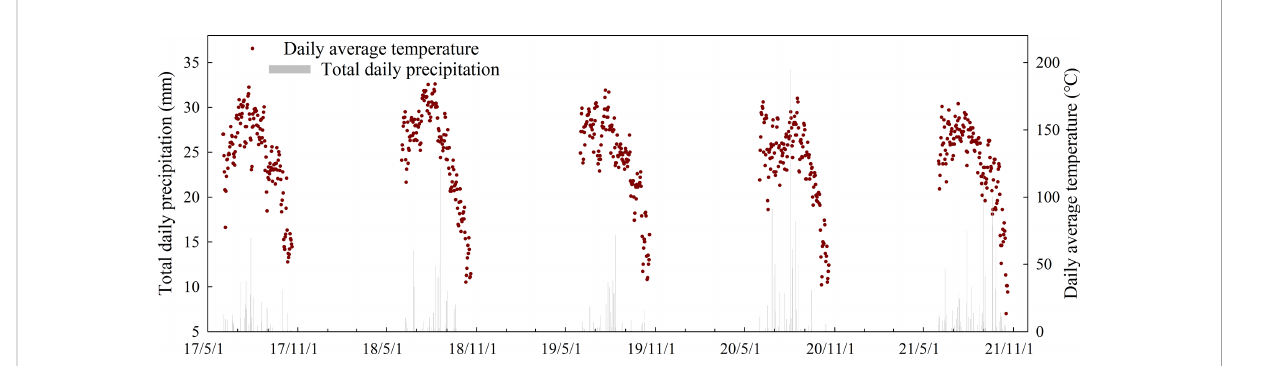
FIGURE 1 The weather conditions during the summer maize growth duration